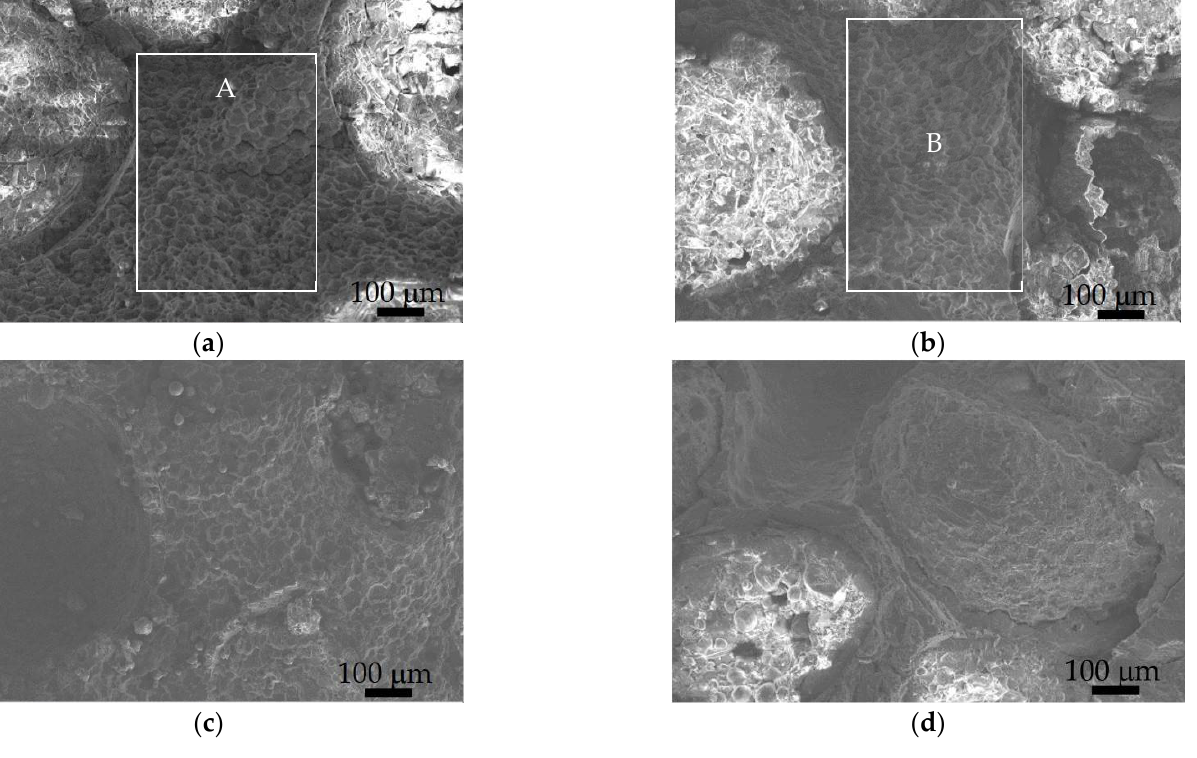
Figure 10. Quasistatic compressive fracture morphology of Al 2 O 3hs /AZ91D prepared at different sintering temperatures: ( a ) 663 K, ( b ) 693 K, ( c ) 723 K, and ( d ) 753 K.